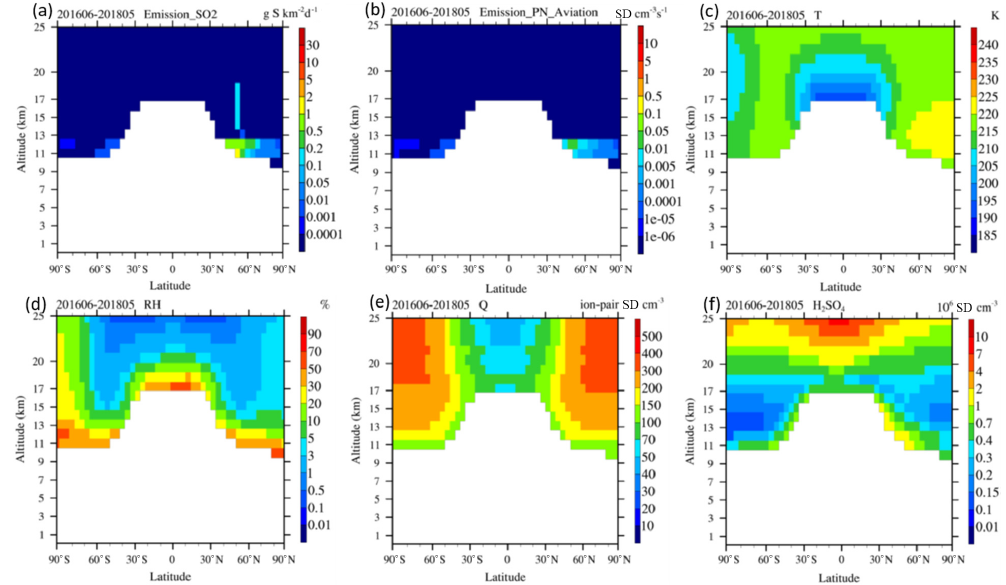
Figure 2. Zonal mean SO 2 _emit, PN_Emit, T , RH, Q , and H 2 SO 4 averaged during the 2-year period (June 2016–May 2018) covering ATom 1–4. To focus on the lower stratosphere, only the values of these variables in grid boxes with more than 50% of time above the tropopause and below 25km are